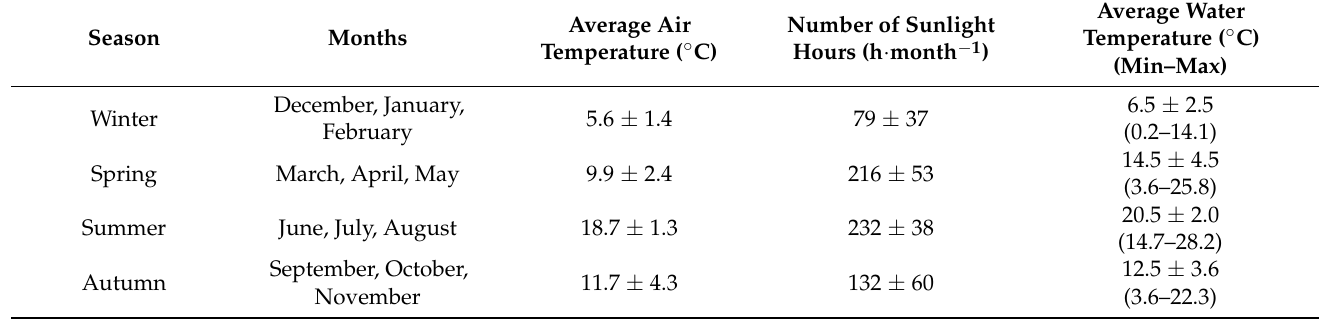
Table 1. Average air temperature under shelter ( ◦ C) and number of sunlight hours (h · month − 1 ) for the different seasons during the period of study. Values to the right of ( ± ) are the standard deviations.